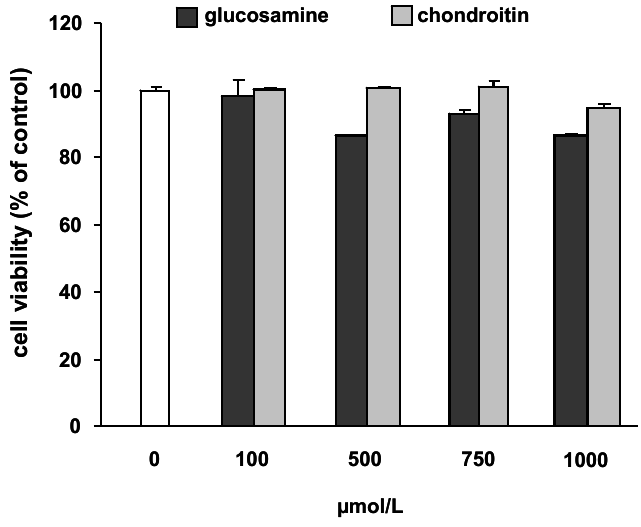
Figure 1. Effect of glucosamine and chondroitin on cell viability in SW1353 cells. Cells were treated with increasing concentrations of test substances for 24 h. The test compounds did not impair cell viability at any of the concentrations tested. Cytotoxicity was determined by the neutral red assay and cell viability is expressed as percentage of control (untreated